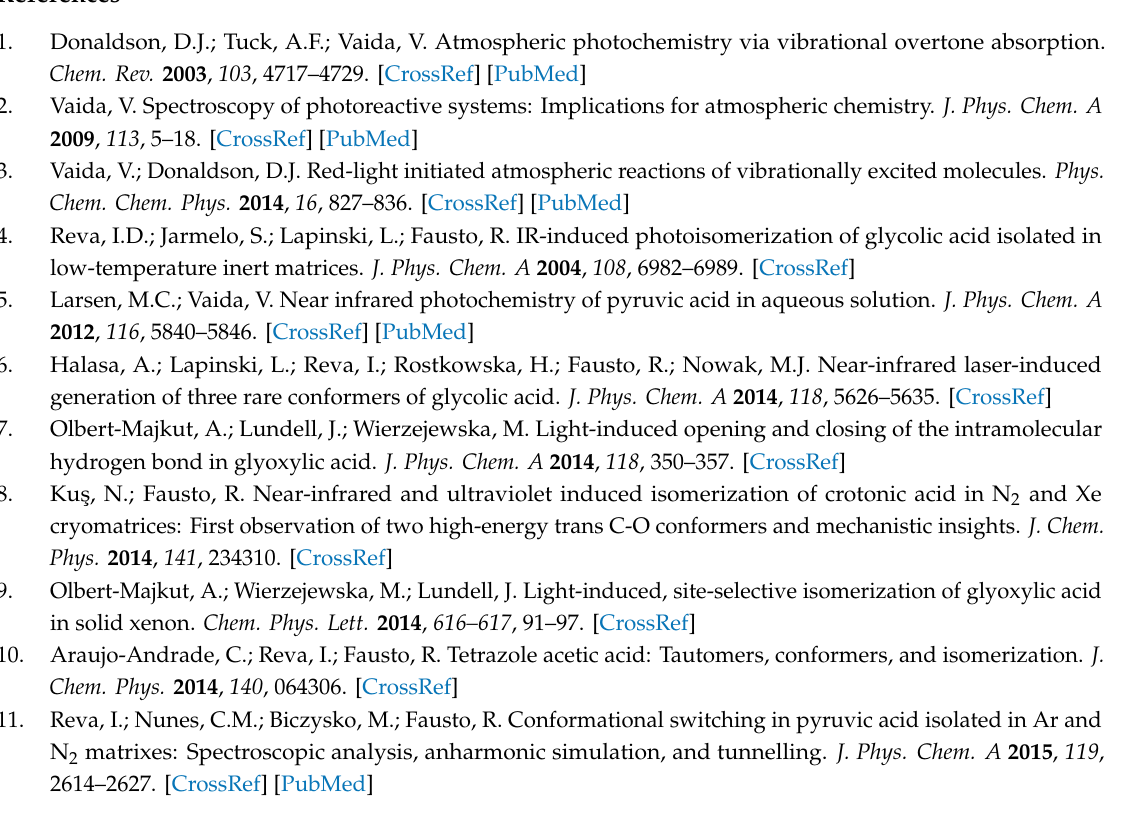
Supplementary Materials: The following are available online: Figure S1. The δ OH regions of the infrared spectra obtained for the 1:1 complex formed between SSC and N 2 (SSC1): ( a ) After co-deposition GA with N 2 / Ar = 1 / 4000 at 18 K / 10 K; ( b ) upon 360 min irradiation at 1438, 1440, or 1442 nm; ( c ) upon annealing at 33 K / 10 K; Figure S2. The ν C = O region of the infrared spectra of SSC, GAC, and AAT monomers and their complexes with nitrogen: ( a ) After deposition GA / Ar at 18 K / 10 K and two subsequent irradiations at 1438 and 1400 nm; ( b ) after co-deposition GA with N 2 / Ar = 1 / 4000 at 18 K / 10 K; (c,d,e) upon 360 min irradiation at 1438, 1440, or 1442 nm, respectively; Figure S3. Plots of the integrated intensity of the selected bands of AAT1 and AAT3 versus time of irradiation; Table S1. The ν C = O shifts and intensities in GA complexes with nitrogen at di ff erent levels of theory; Table S2. Experimental positions of the ν C = O bands and their shifts observed for GA ... N 2 complexes in argon matrices. Author Contributions: Conceptualization, M.W. and J.L.; methodology, M.W. and J.L.; formal analysis, J.K.,